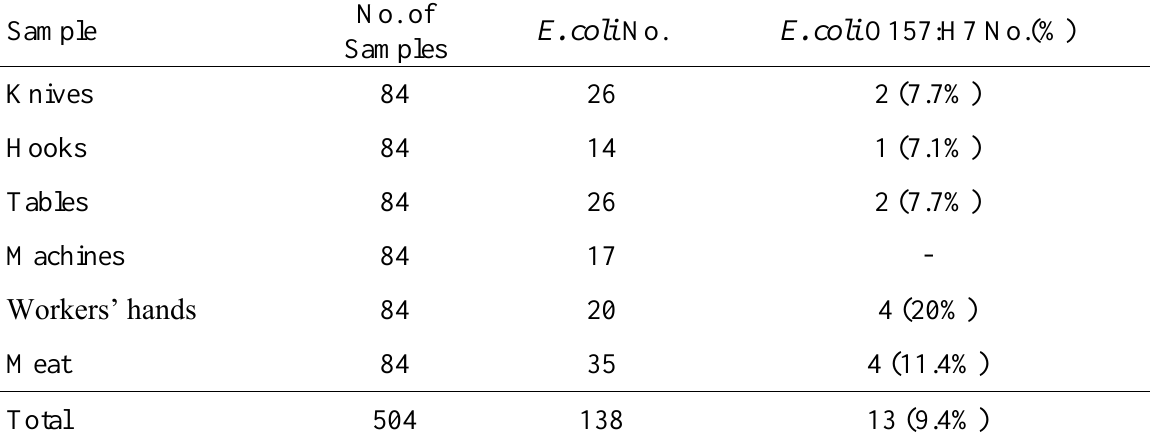
Table 2: Number and percentage of positive E. coli O157:H7 isolated from meats and butchers’ shops.